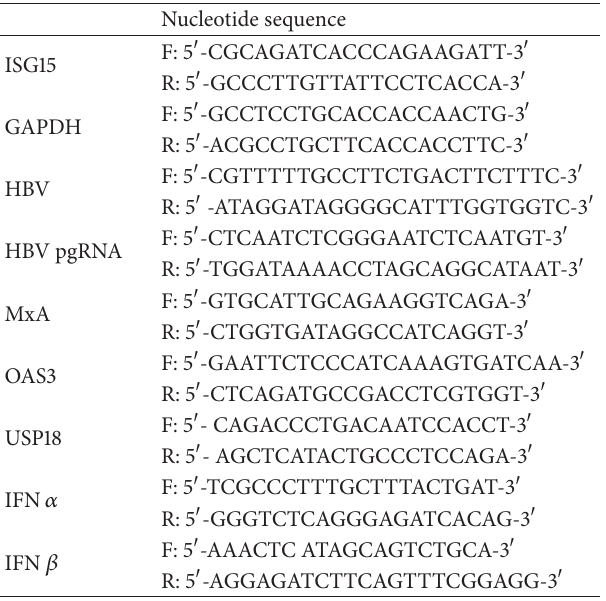
Table 1: Primers used for real-time